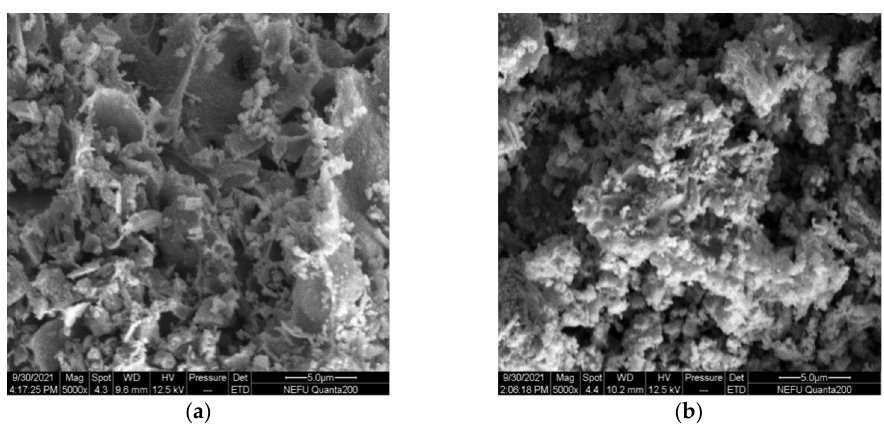
The SEM micrographs of La 0.8 Ce 0.2 Co 0.7 Fe 0.3 O 3 and La 0.8 Ce 0.2 Co 0.7 Mn 0.3 O 3 perovskite-